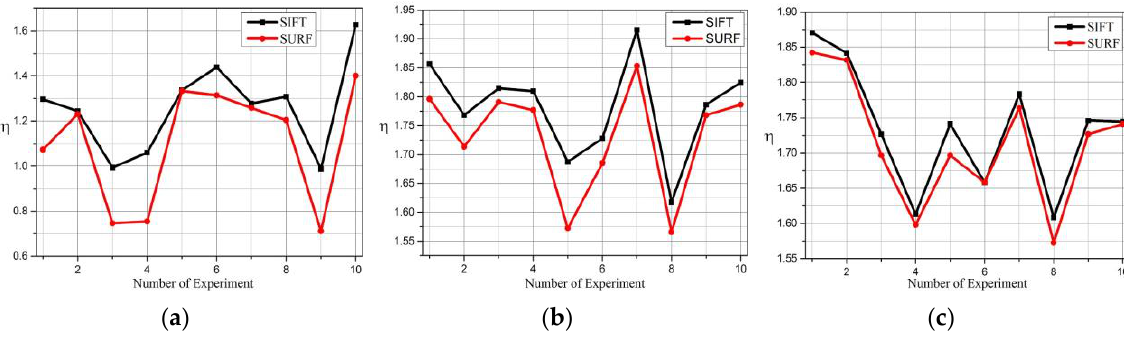
Figure 5. ( a ) the impact of scale changes on image matching factor; ( b ) the impact of rotation on matching factor; ( c ) the impact of blur on image matching image matching factor; ( c ) the impact of blur on image matching factor.